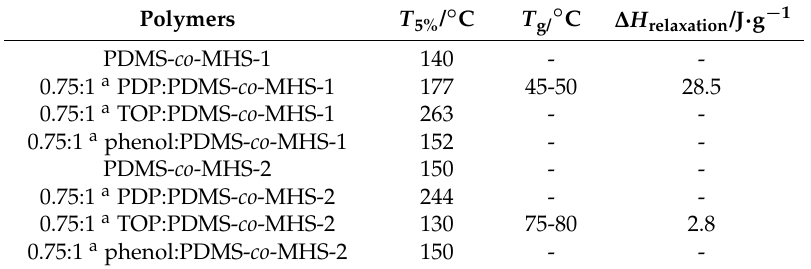
Figure 2. Synthesis of linear phenoxy-substituted polysiloxanes by the Piers–Rubinsztajn (PR) reaction (Reproduced from Reference [12] with the permission). Table 1. Summary of thermal properties of all phenoxylated polymers and the unmodified base polymers (Summarized from Reference [12]).